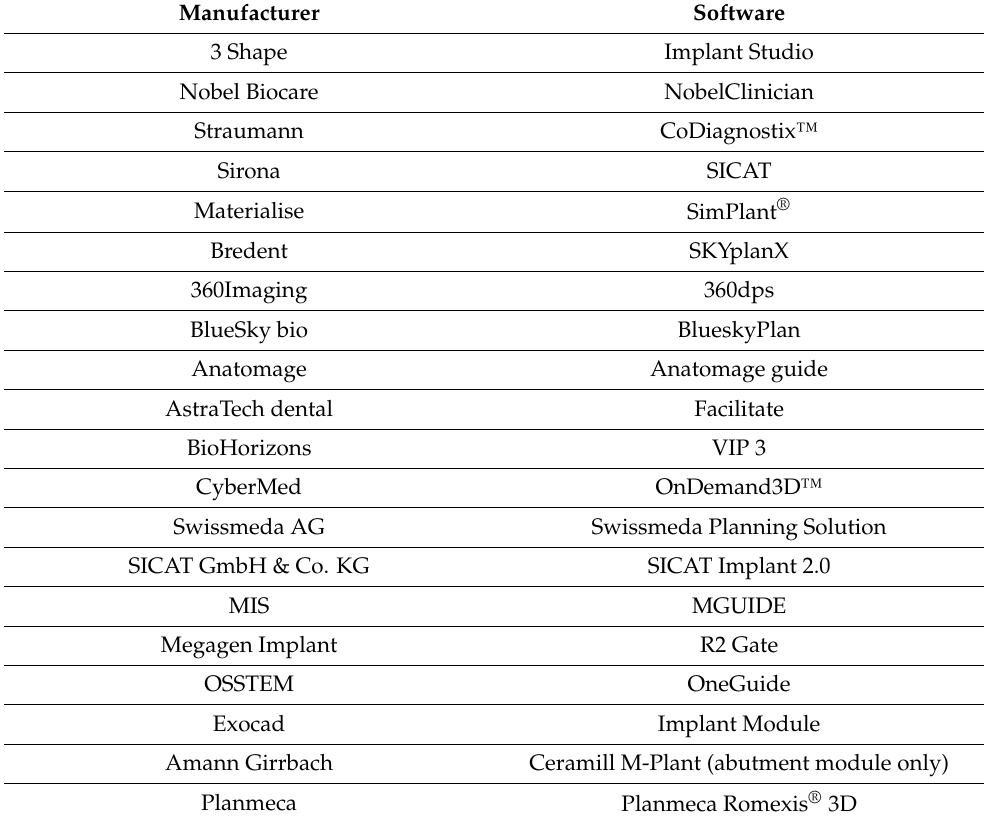
Table 1. Example of a static guided implant planning system in the